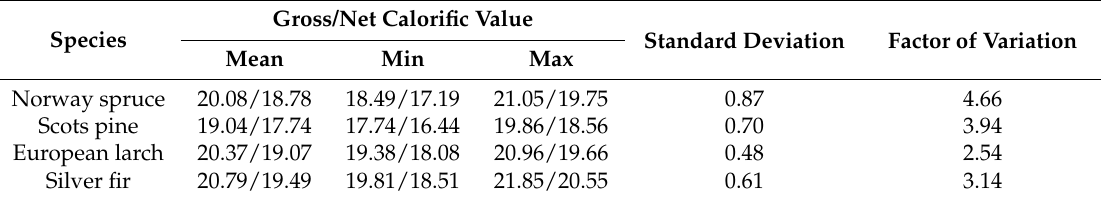
Table 3. Gross and net calorific values for spent cones of the studied tree species (dry bases), in MJ · kg − 1.